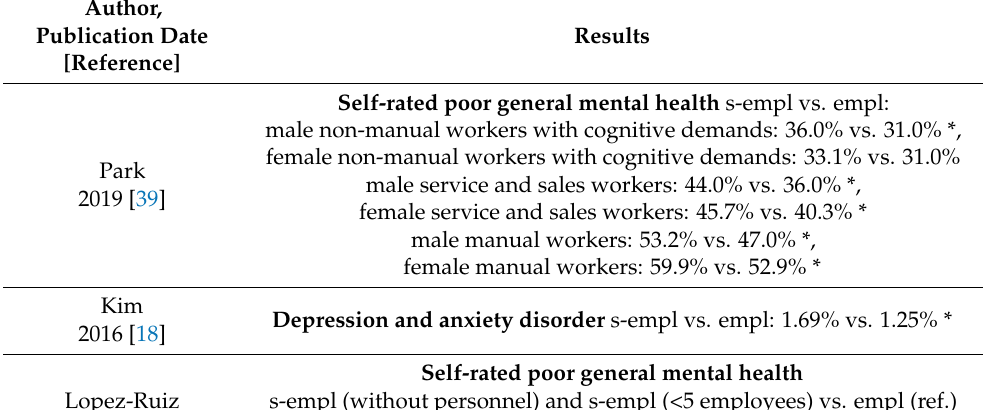
Table 10. Self-rated poor general mental health —results of cross-sectional studies of good quality on mental disorders comparing self-employed (s-empl) vs. employees (empl).